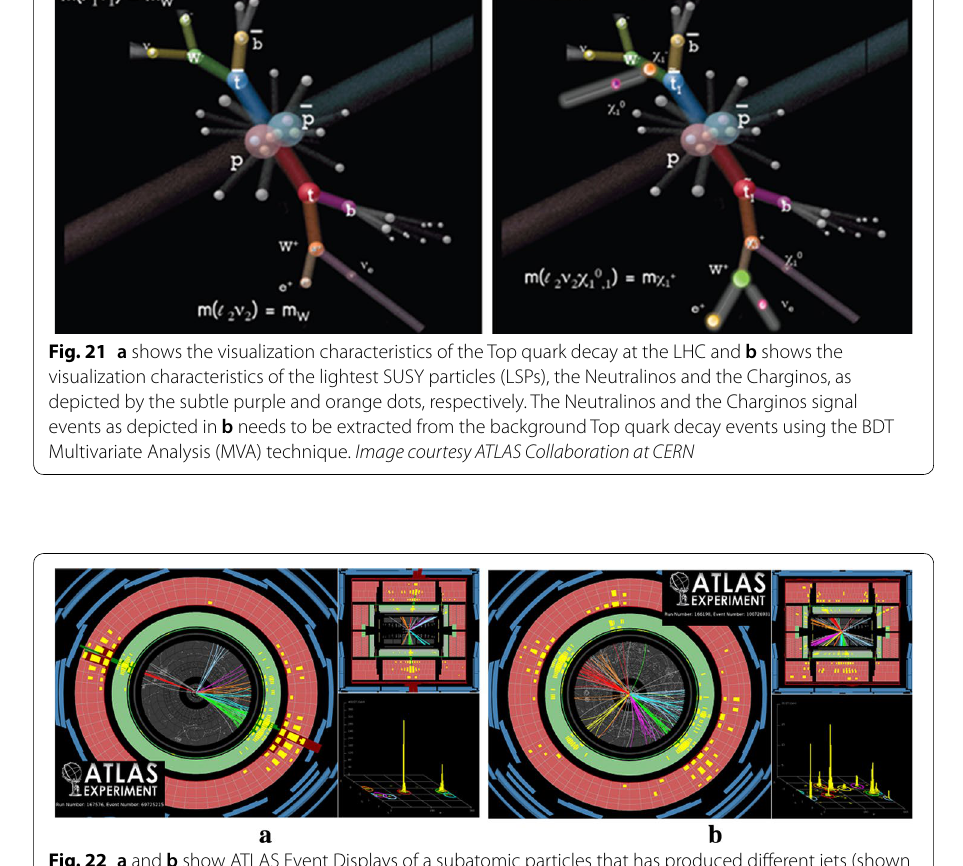
Fig. 22 a and b show ATLAS Event Displays of a subatomic particles that has produced different jets (shown in different colors) which has been tagged using the BDT-based b-tagging technique. Image courtesy ATLAS Collaboration at